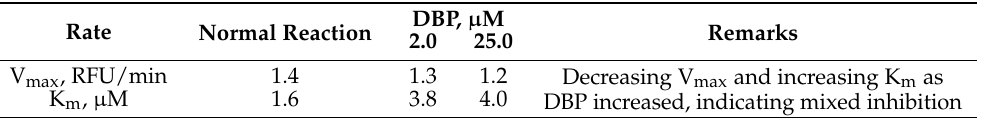
Figure 5. Michaelis − Menten analysis ( a ) indicates DBP increased the K m but decreased the V max values. For more accurate V max and K m value determination, the Lineweaver − Burk graph was plotted ( b ). GSK-3 β inhibition by DBP is significant with p = 0.0017 (mixed inhibition). Table 4. The evaluation of V max and K m from Lineweaver–Burk plot. The changes in V max and K m patterns between normal and inhibited reactions were used to determine the inhibitory mechanisms of DBP against GSK-3 β .